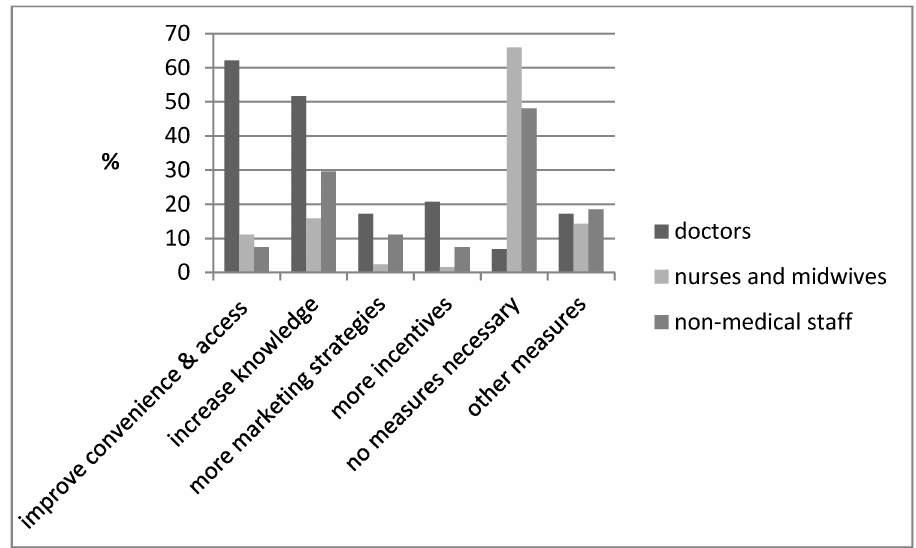
Figure 3: Strategies reported that could improve vaccination coverage (182 staff members responded to the